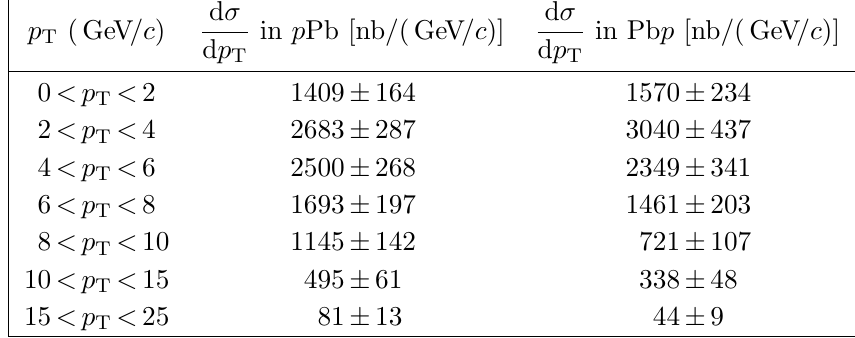
Table 6 . (cid:7) (1 S ) production cross-section in p Pb and Pb p , as a function of p T .